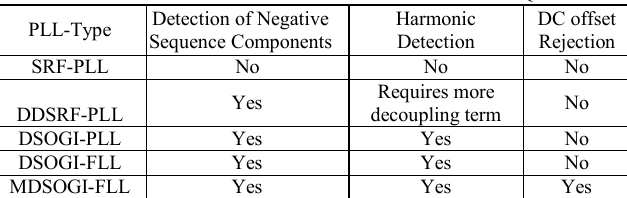
Fig. 8. Comparison of performance of various frequency estimation methods. TABLE II P ERFORMANCE E VALUATION O F D IFFERENT PLL T ECHNIQUES